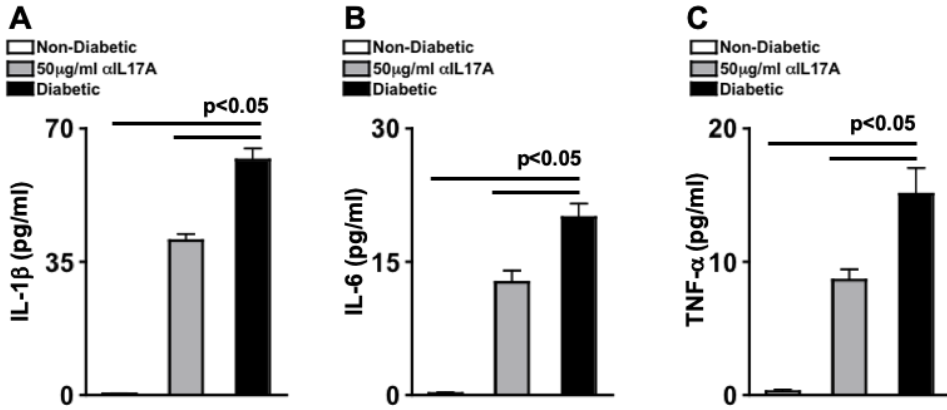
Figure 5. Inflammatory Cytokines in the Retinas of db/db Mice Treated with anti-IL-17A. Levels of IL-1  ( A ), IL-6 ( B ), and TNF-  ( C ) in protein lysates of individual retinas (n = 9/group) of